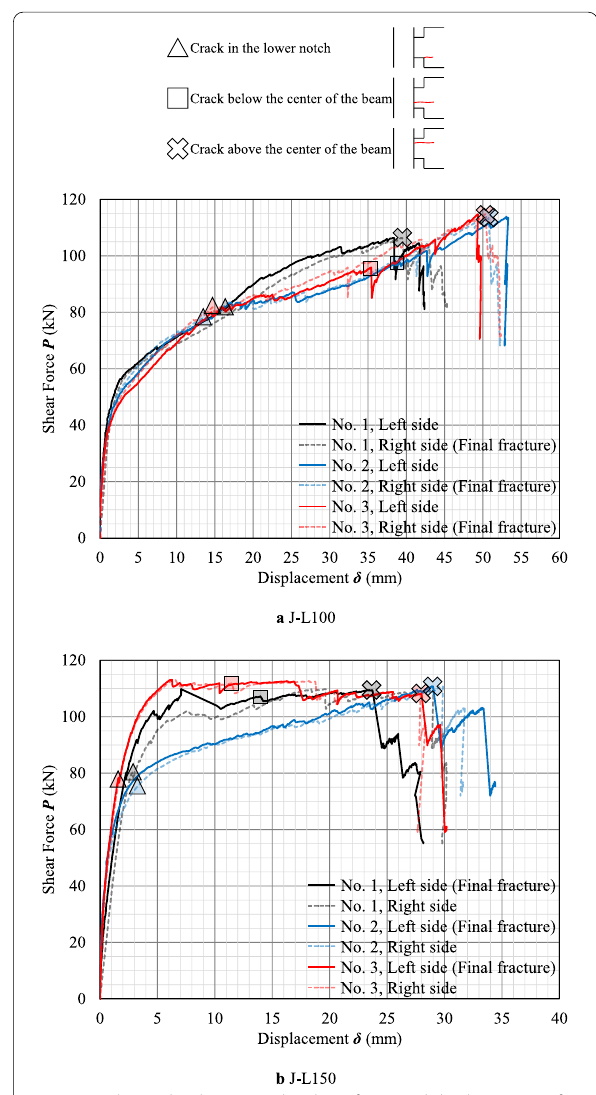
Fig. 16 Relationship between the shear force and displacement of the